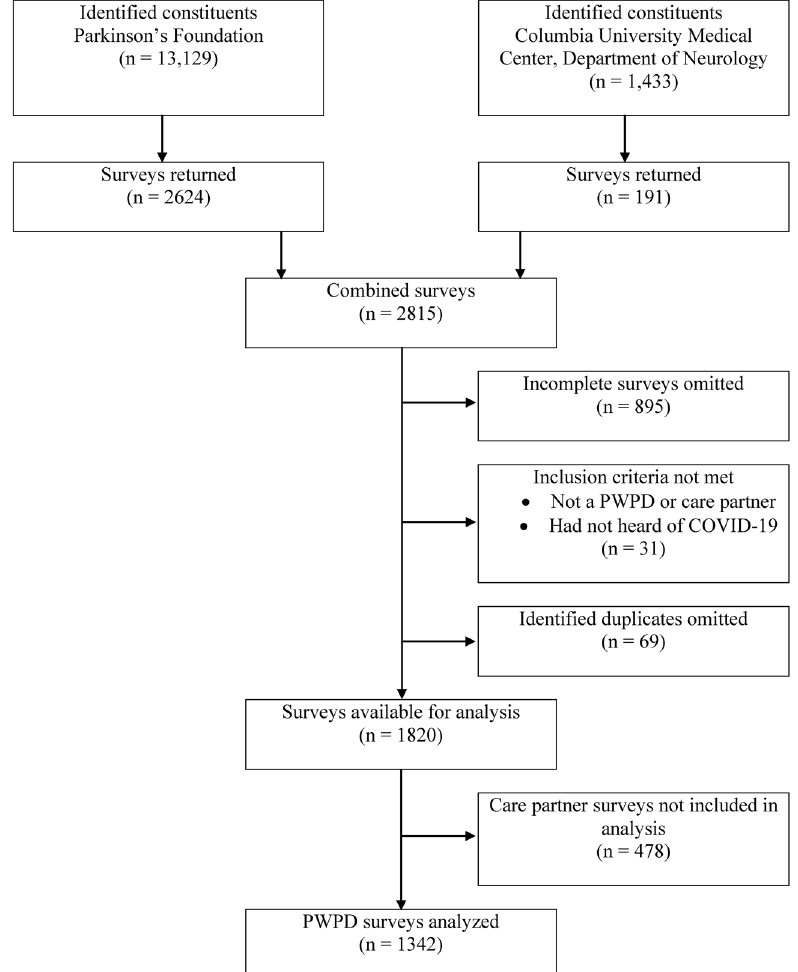
Fig. 2 Flowchart of data cleaning approach. PwPD people with Parkinson ’ s